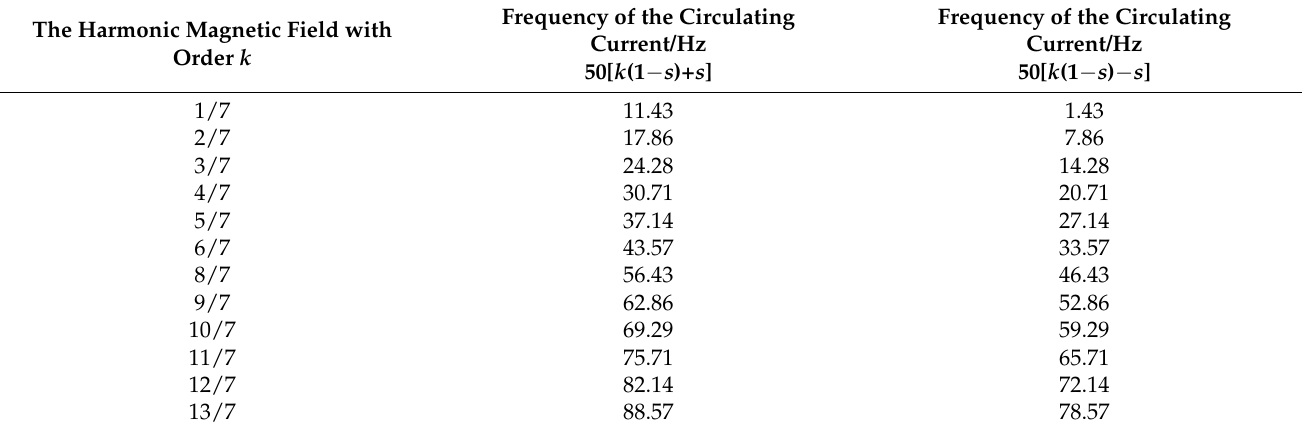
Table 2. The theoretical characteristic frequency of the circulating current between stator